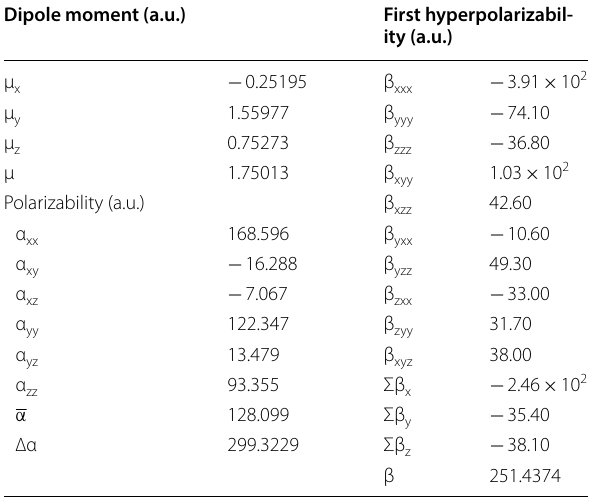
Table 7 Calculated dipole moments (D), polarizabil- ity and the first hyperpolarizability components (a.u.) for ligand compounds Dipole moment (a.u.) First hyperpolarizabil‑ ity